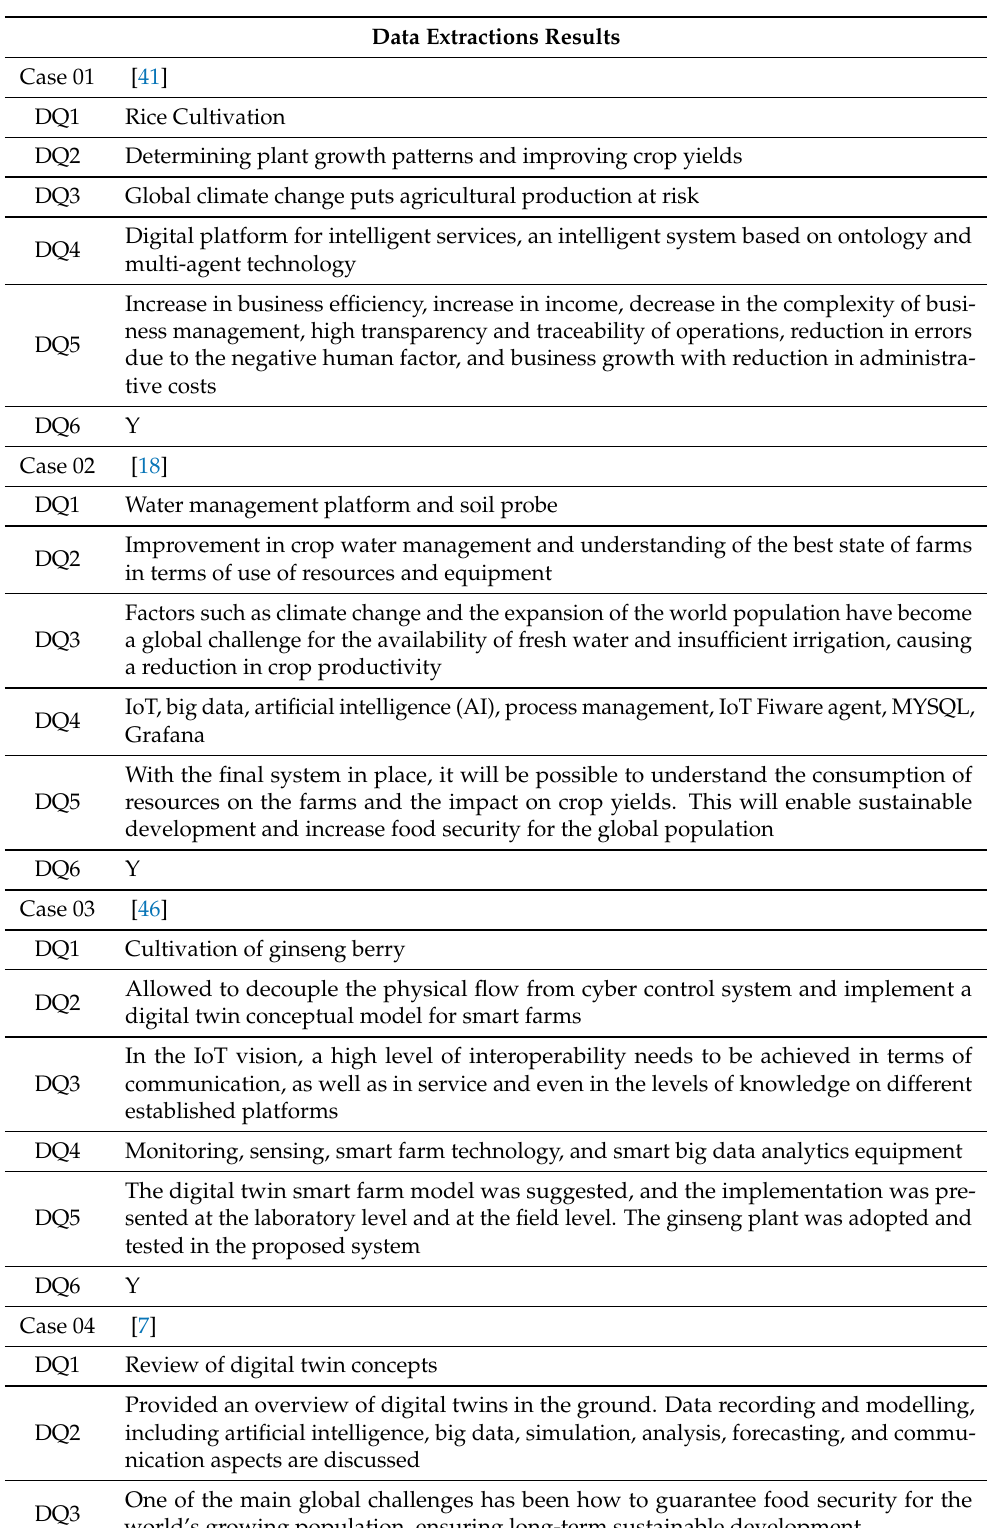
Table 14. Data Extractions